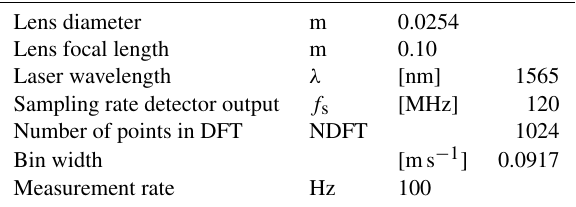
Table 2. Physical properties of the lidar.